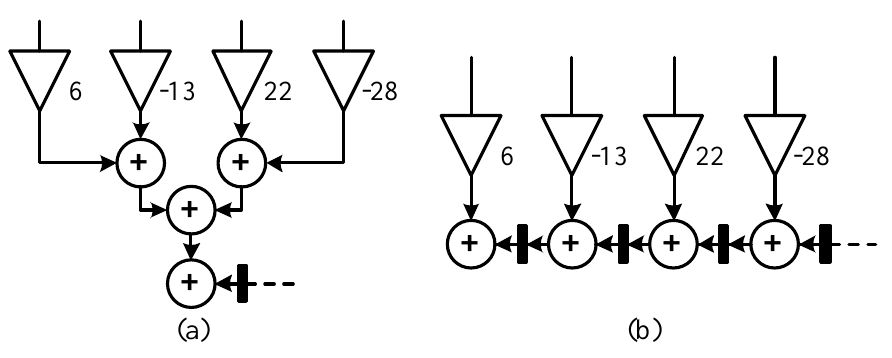
Figure 5. LSAs and corresponding structural